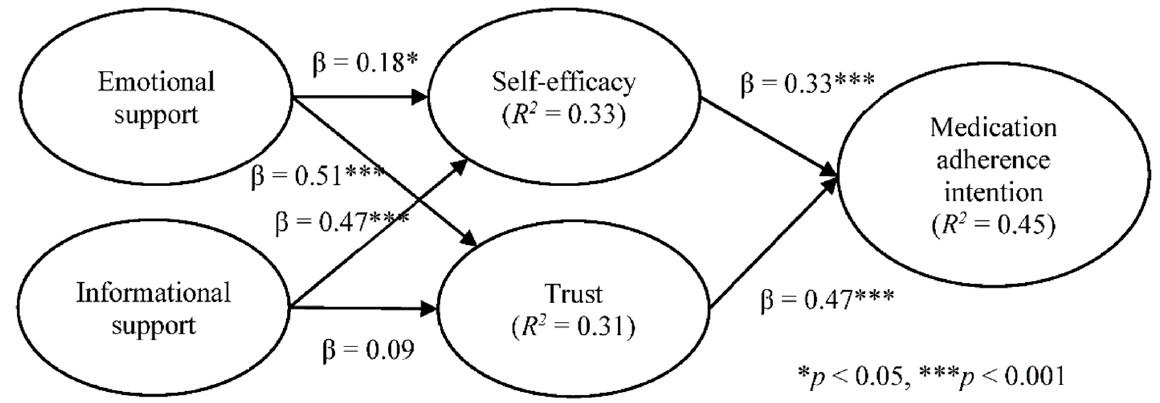
Figure 3. Structural model results for healthcare professional communities.